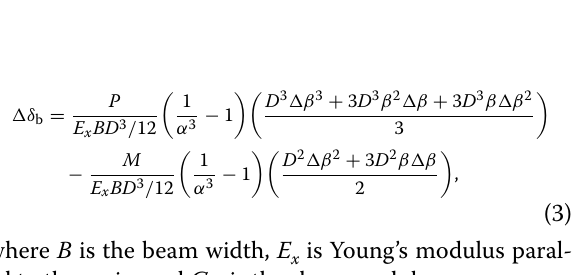
the crack occurs can be calculated using Eq. (5). (4)